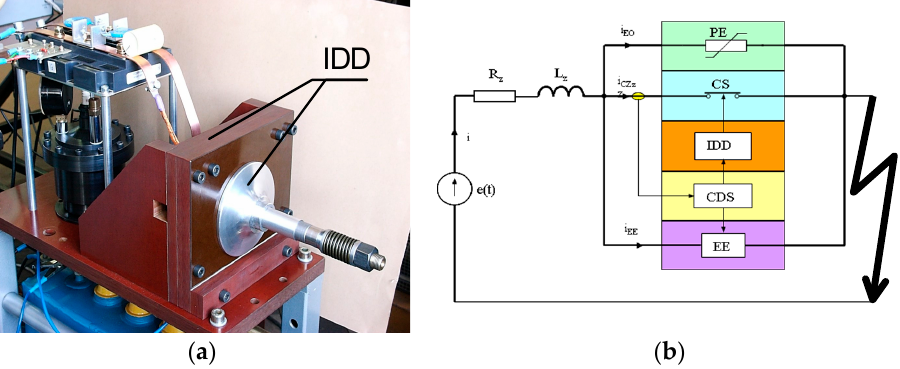
Figure 1. Current limiting interrupting device (CLID): ( a ) CLID photo ( b ) Block